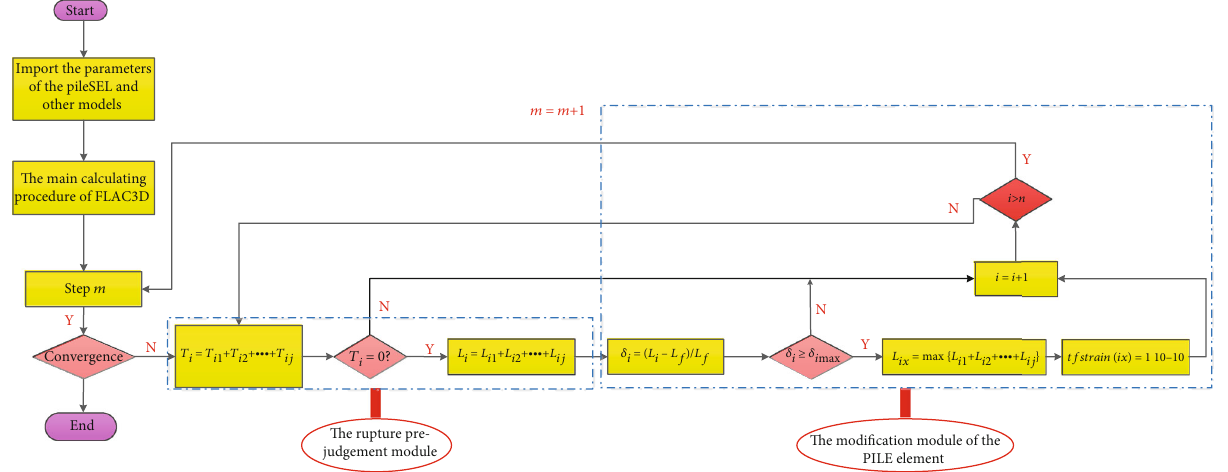
Figure 6: The procedures to realise the modi fi ed tensile rupture mechanical model of the